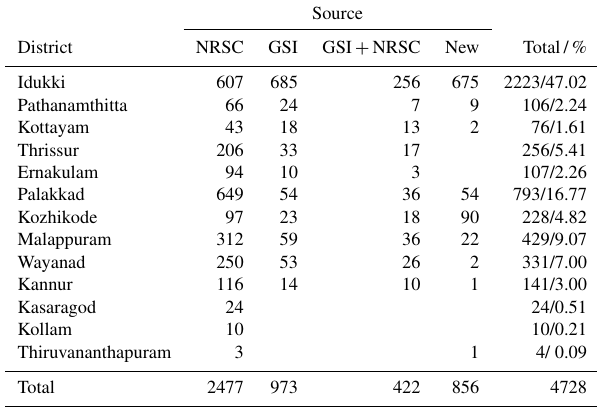
Table 1. The number of landslides per district in Kerala from the final dataset with various sources.